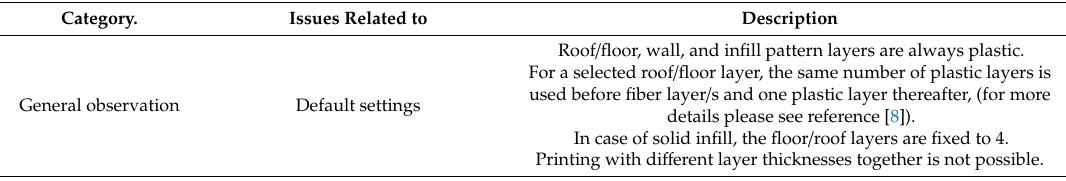
Table 3. Observations on the Eiger slicer.